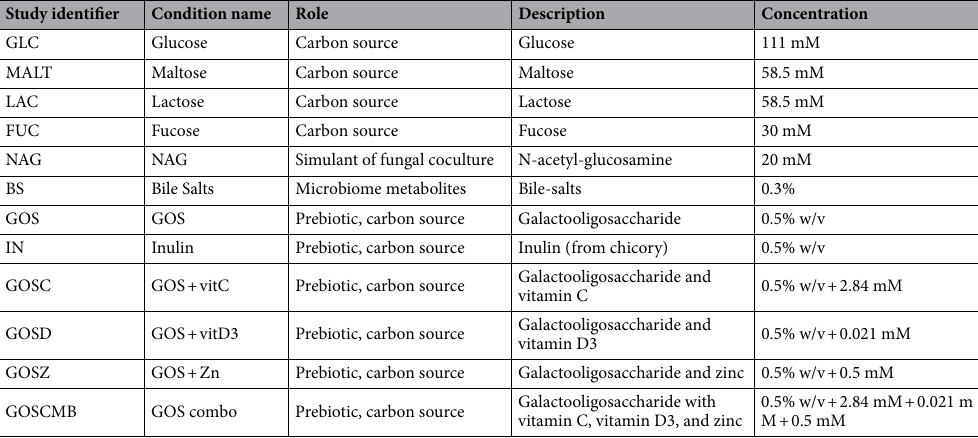
Table 2. List of prebiotics and/or additives and their concentrations used in the